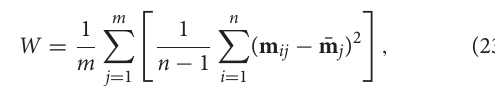
FIGURE 2 | Convergence metrics for the grid point denoted by a vertical dashed line in Figure 1. (A) The trace for each sampler and for each variable. The traces indicate full exploration of the parameter space. (B) histograms of each variable for each sampler. (C) The auto-correlation for thickness H , mass balance ˙ b , and speed U s . For example, samples for thickness H become uncorrelated after approximately 8000 iterations.